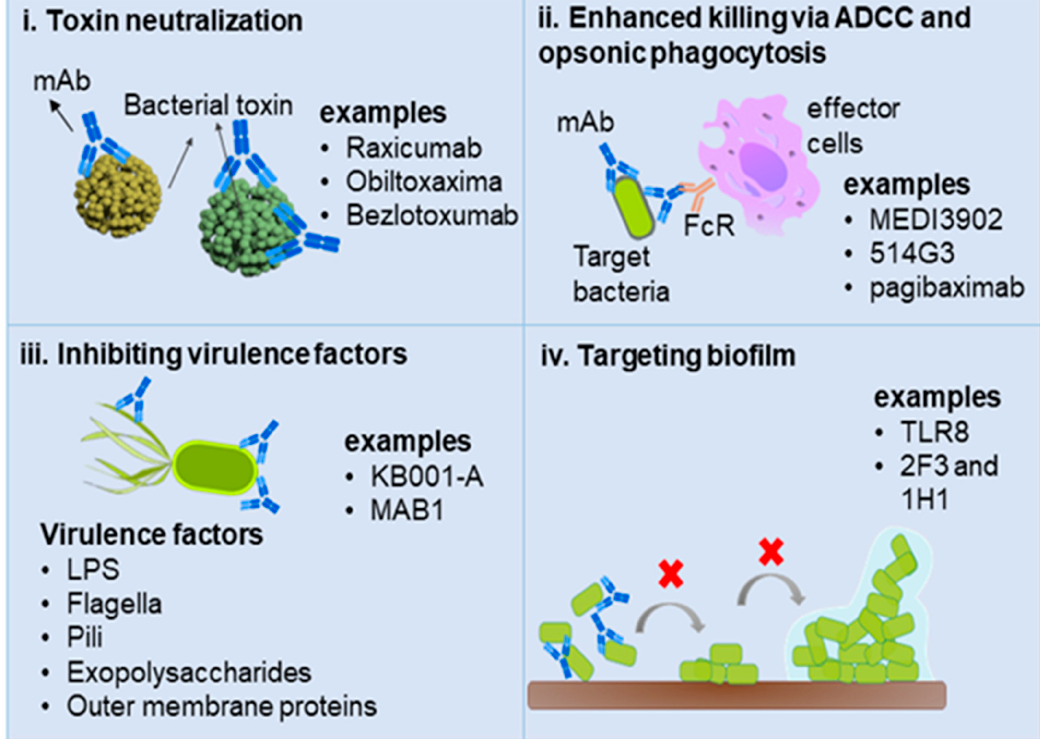
Figure 2. Examples of mAbs that target bacteria with their general mechanism of action.